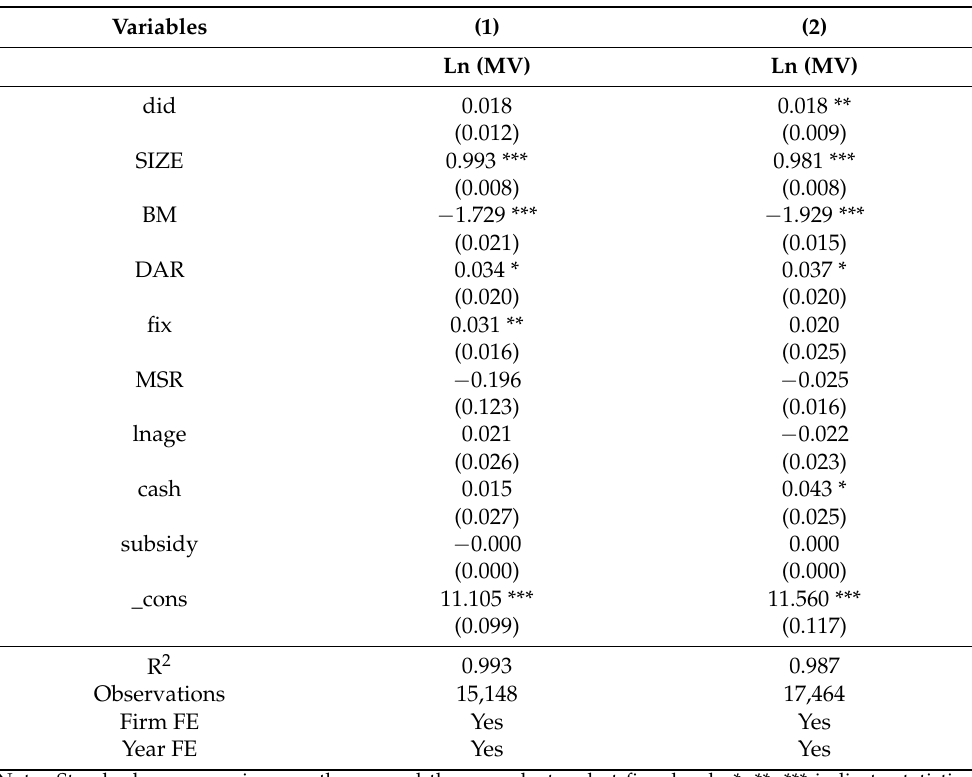
Table 9. Heterogeneous analysis of the impact of firm